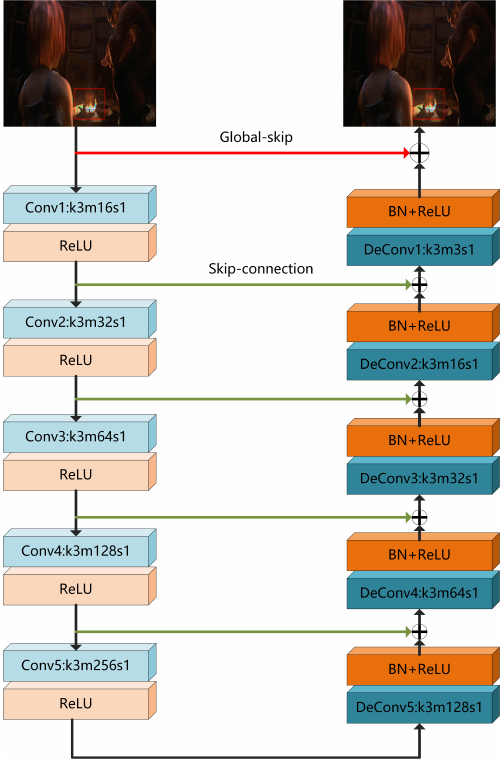
Figure 2. The network structure of the proposed algorithm BE-AUTO